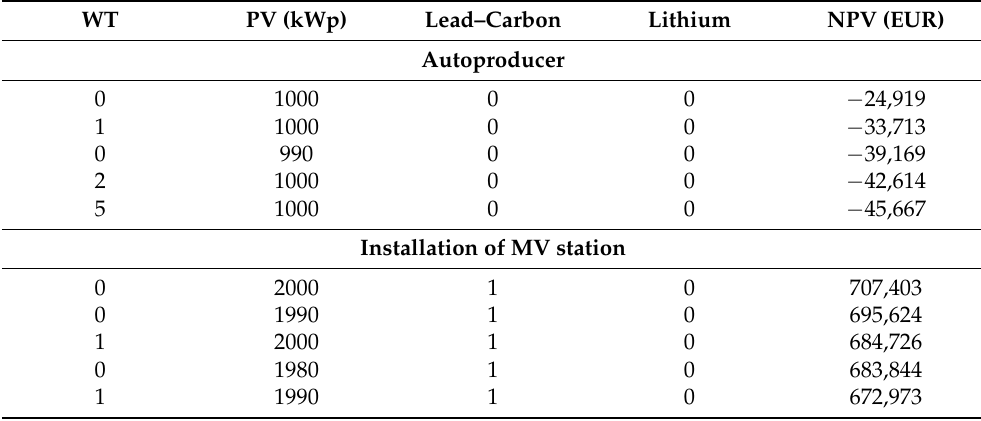
Table 8. Optimal results of the HMU campus microgrid considering 25% battery cost reduction. WT PV